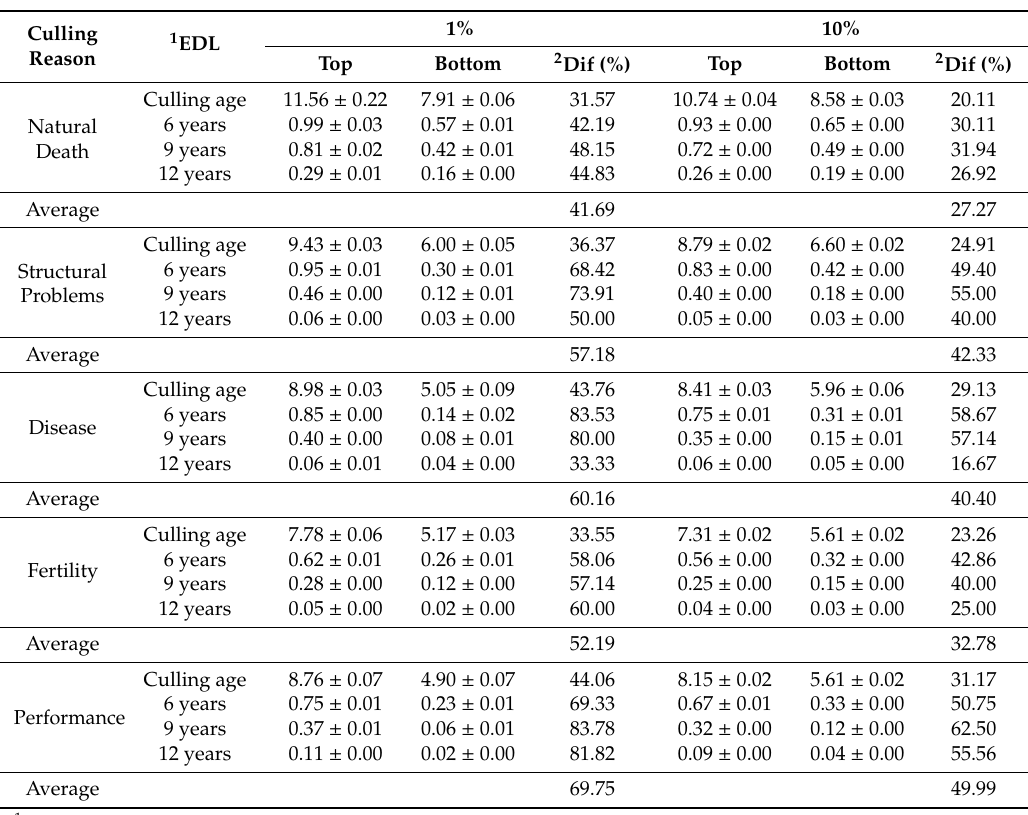
Table 11. Average ( ± SE) expected daughter longevity (EDL) predicted for the top and bottom 1% and 10% sires, considering di ff erent groups of known culling reasons and selection at 4 years-old for functional longevity assuming 0 after the cow was culled, and missing records when no information of calving was found at the specified